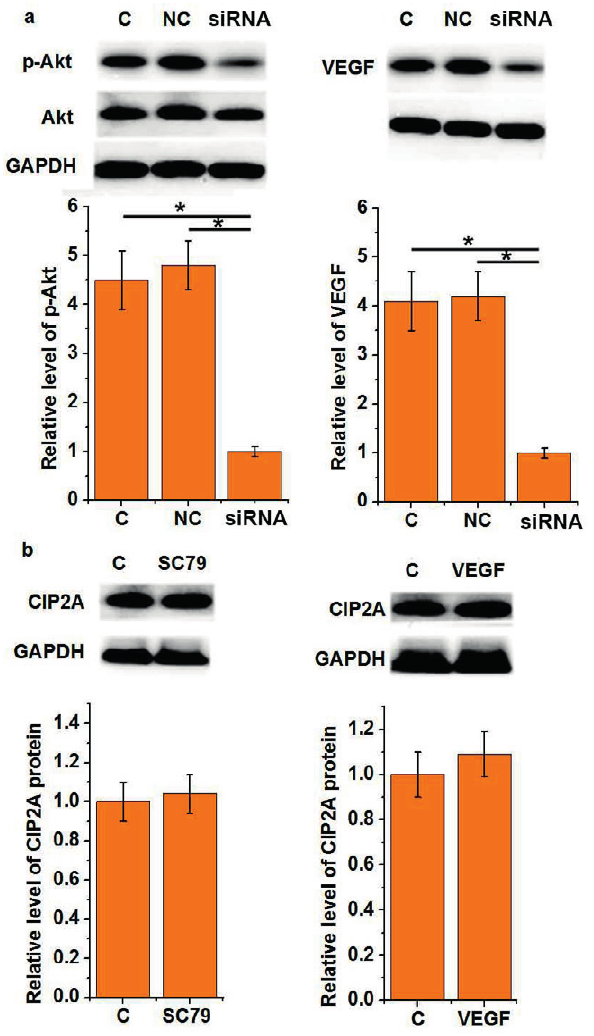
Fig. 4. CIP2A is likely an upstream activator of Akt pathway and VEGF.